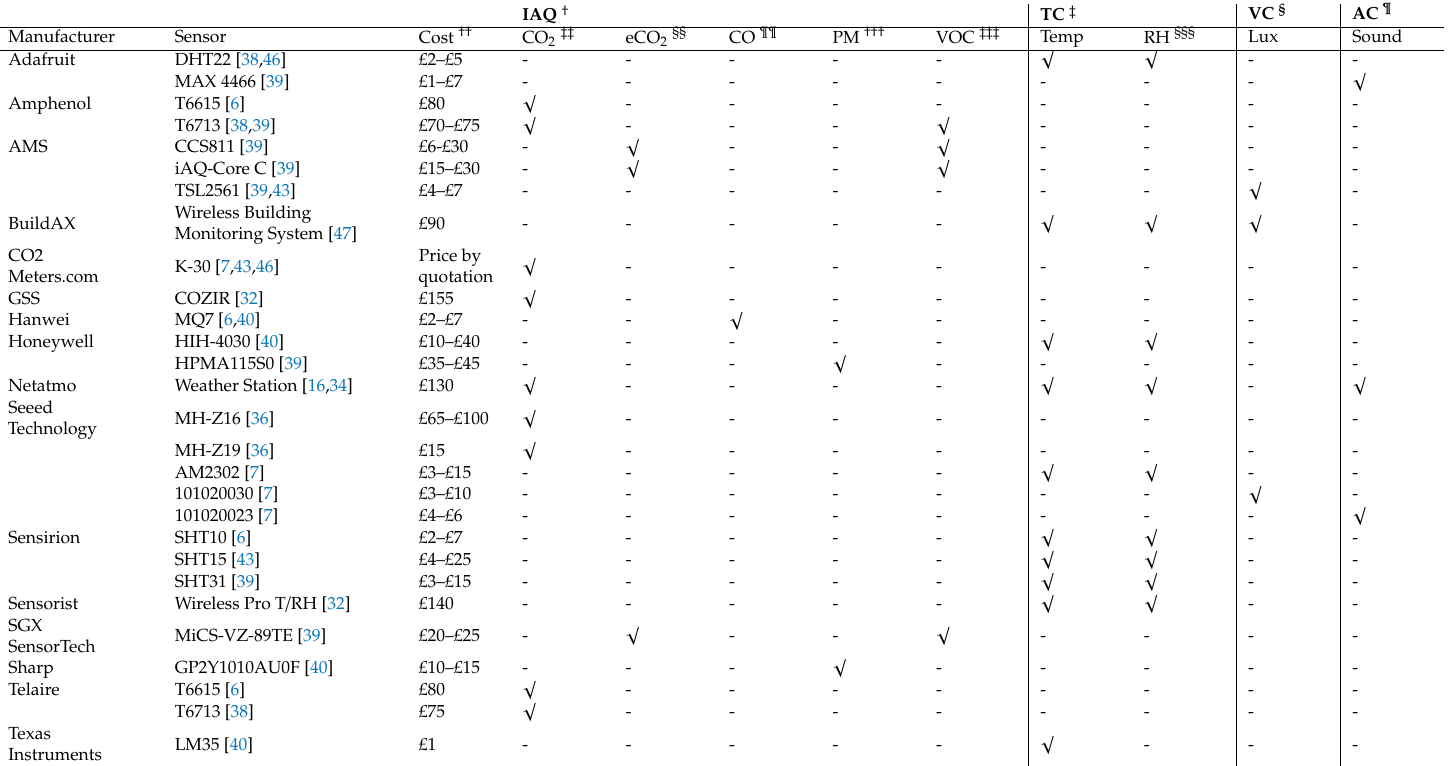
Table outlines low-cost sensors used within the reviewed studies, outlining the manufacturers, models, measurement factors and typical costs. † Indoor Air Quality. ‡ Thermal Comfort. § Visual Comfort. ¶ Acoustic Comfort. †† Costs are approximate and taken from Google Shopping Search Engine – prices vary according to manufacturer and retailer. ‡‡ Carbon Dioxide. §§ Equivalent CO2 (eCO2) is the measure used to communicate the global warming potential of combined greenhouse gasses. ¶¶ Carbon Monoxide. ††† Particulate Matter (PM1.0 / PM2.4 / PM10). ‡‡‡ Volatile Organic Compounds. §§§ Relative